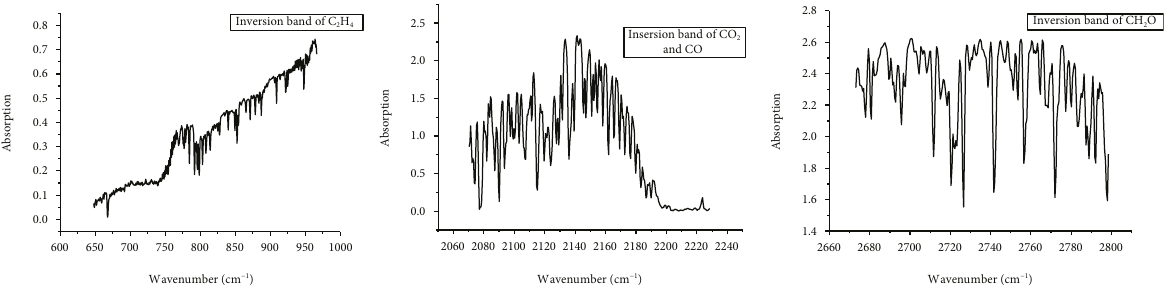
Figure 8: Inversion bands of target gases.